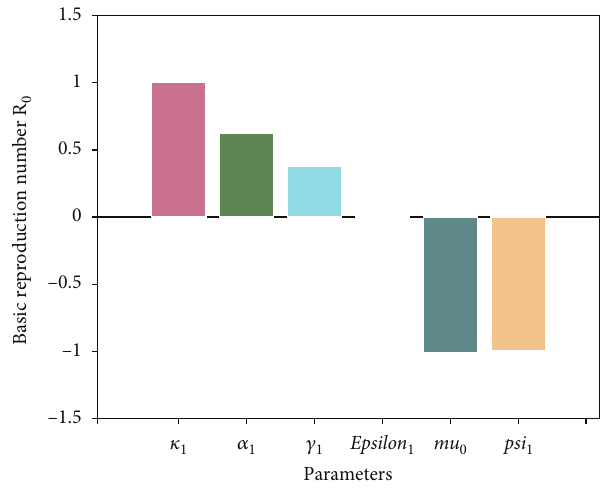
Figure 12: E ff ects of parameters variation on R